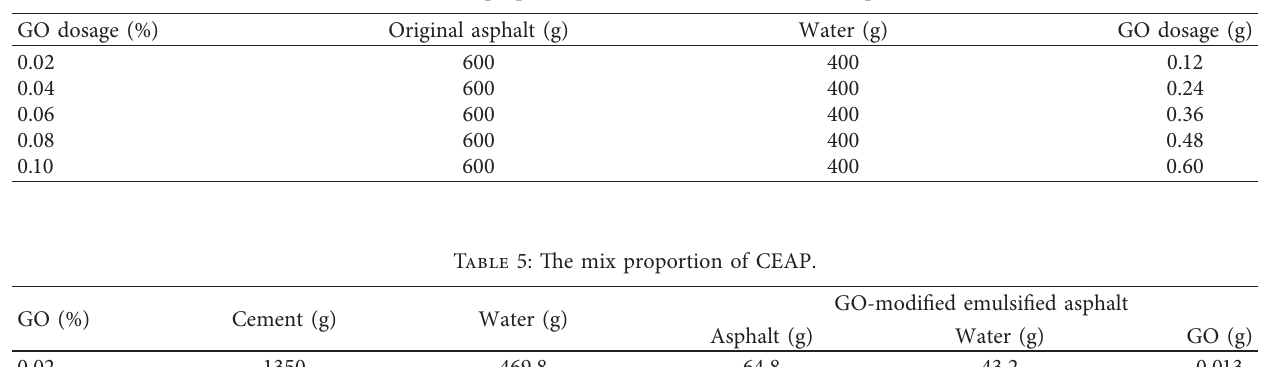
Figure 3: Preparation chart of GO-modified asphalt emulsion. Table 4: Mix proportion of GO-modified emulsified asphalt.